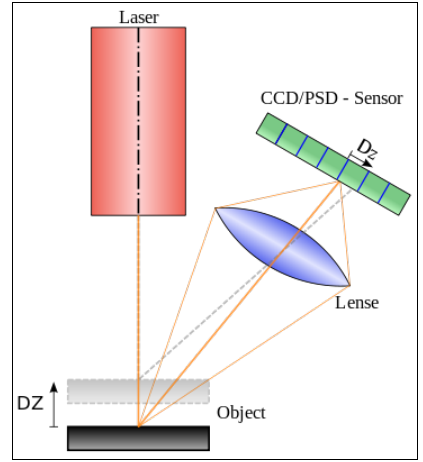
Figure 5. Principle of triangulation (source: